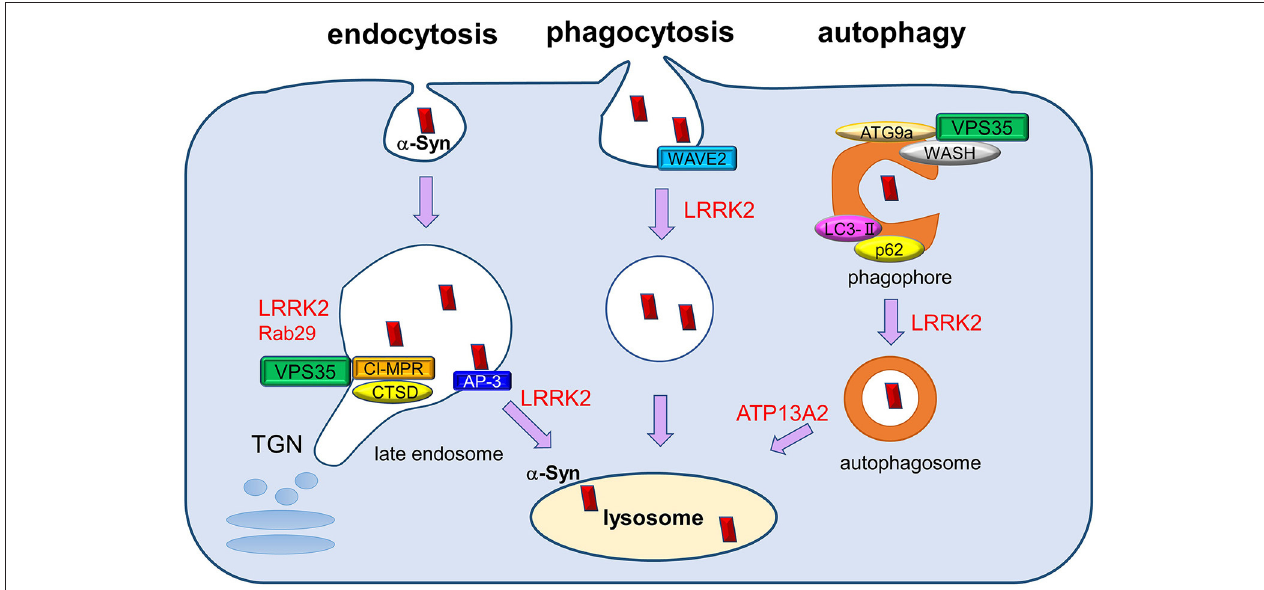
FIGURE 1 | The roles of PD-associated proteins in endolysosomal pathways responsible for α -synuclein degradation. Extracellular and intracellular α -synuclein species (both soluble and aggregated) are transported into lysosomes for degradation through several pathways, including endocytosis, phagocytosis, and autophagy. PD-associated proteins VPS35, LRRK2, and Rab29 influence multiple steps of these degradation pathways, both individually and cooperatively. The retromer complex component VPS35 regulates the recycling of cathepsin D (CATD), the main lysosomal hydrolase responsible for α -synuclein degradation, by retrieving the lysosomal hydrolase receptor CI-MPR from endosome to the TGN. VPS35 pathogenic mutation may affect the recycling of CATD and thus impair α -synuclein degradation. LRRK2 and Rab29 further interact with VPS35 and regulate its function cooperatively. In endocytosis pathway, LRRK2 regulates AP-3-mediated intracellular recycling of lysosomal membrane proteins, whereas LRRK2 modulates the phagocytic activity by interacting with actin-cytoskeletal regulator WAVE2. VPS35 has been shown to function in macroautophagy pathway together with its interactors WASH complex and ATG9a, thereby regulating the transport of LC3-positive compartments. LRRK2 also regulates the autophagic flux, and ATP13A2 influences the clearance of autophagosomes. The perturbation of macroautophagy pathway is thought to contribute to the impaired degradation of α -synuclein, especially those of aggregated